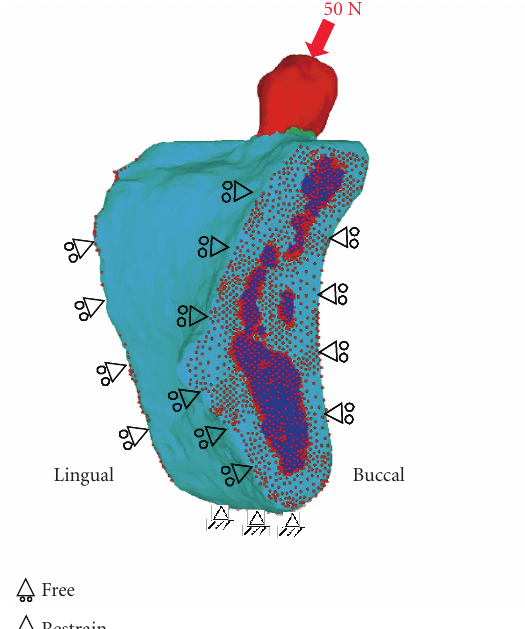
Figure 2: Geometrical and boundary conditions. A buccolingual force at a 45-degree oblique angle to the tooth axis was concentrated onto a single contact point, and static occlusal load of 50 N was applied to the premolar buccal cusp of teeth. Inferior border of the mandible was assumed to be